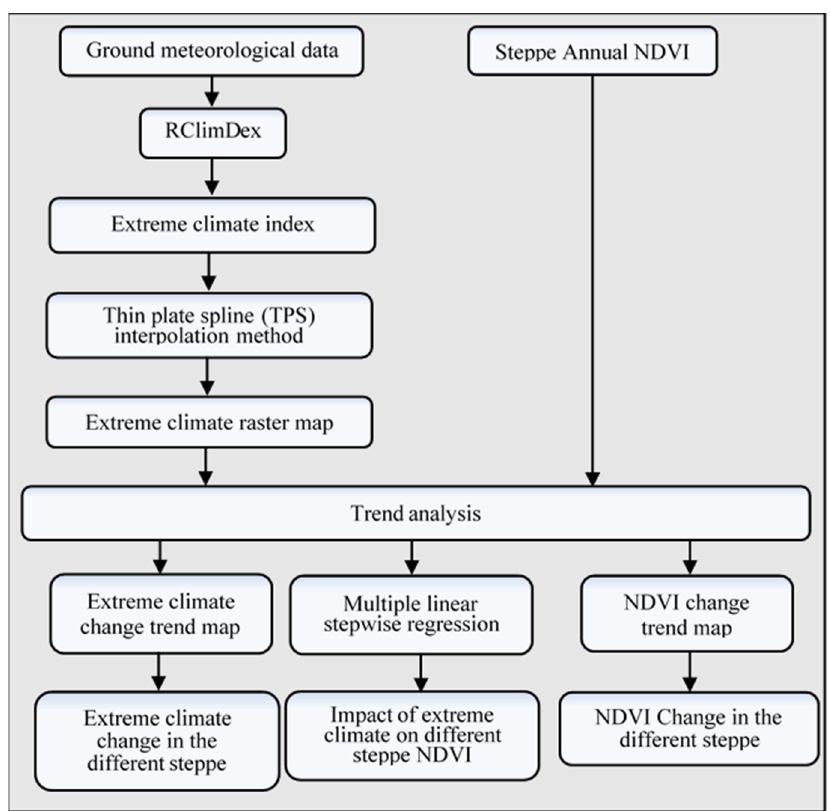
Figure 2. Algorithm flowchart for determining the influence of extreme climate on different steppe areas. NDVI , normalized difference vegetation index.